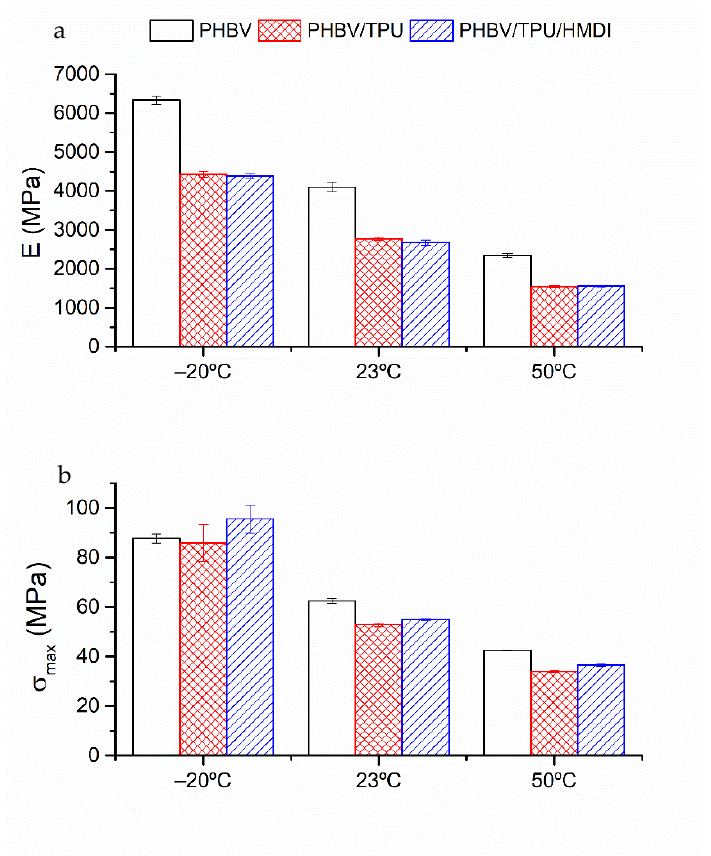
Figure 9. The flexural mechanical properties as a function of temperature of the neat PHBV and PHBV/TPU blends: ( a ) Modulus of elasticity, ( b ) Flexural strength.